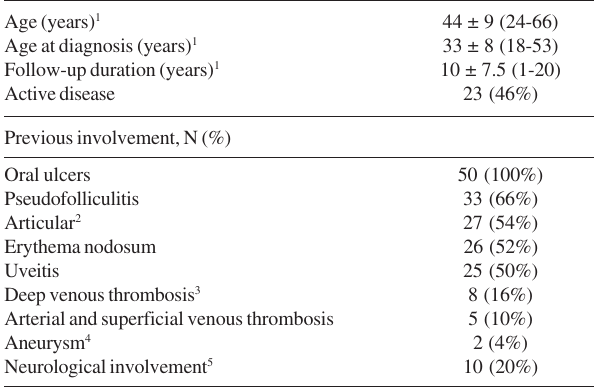
Table 1 - Clinical features of the 50 Behçet Disease patients in this